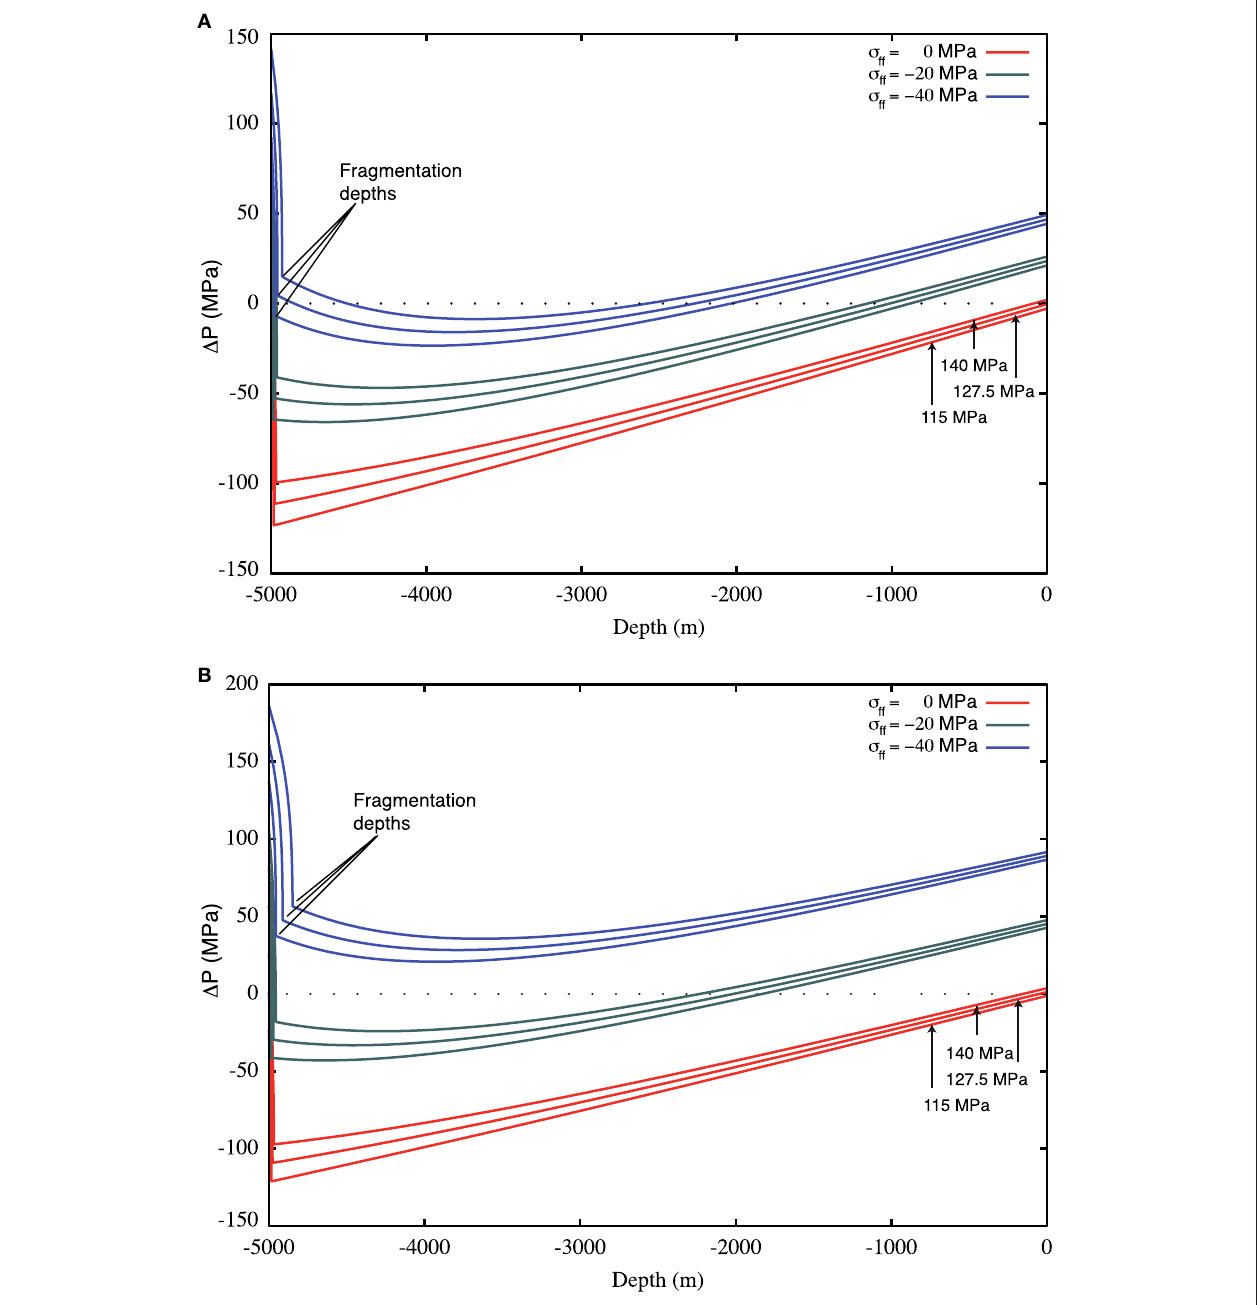
FIGURE 3 | Pressure difference (magma pressure—lithostatic loading—tensile stress) profile along the vertical axis of the shallow dyke conduit obtained using the analytical solution presented by Gao (1996) for a pressurized magma chamber at 5km depth (at lithostatic pressures and ± 12.5MPa, as indicated) under the effect of different far-field extensional stresses (from 0 to − 40MPa, as indicated in the figures), for a unpressurized magma reservoir (A) and a pressurized ( + 10MPa) reservoir at 10 km depth (B). On the top (A) , for an unpressurized magma reservoir σ ff moduli larger then 40MPa are needed to reach neutral conditions along the dyke. On the bottom (B) , the presence of a pressurized magma reservoir reduces the critical extensional stress needed to reach neutral conditions at 20–30MPa.